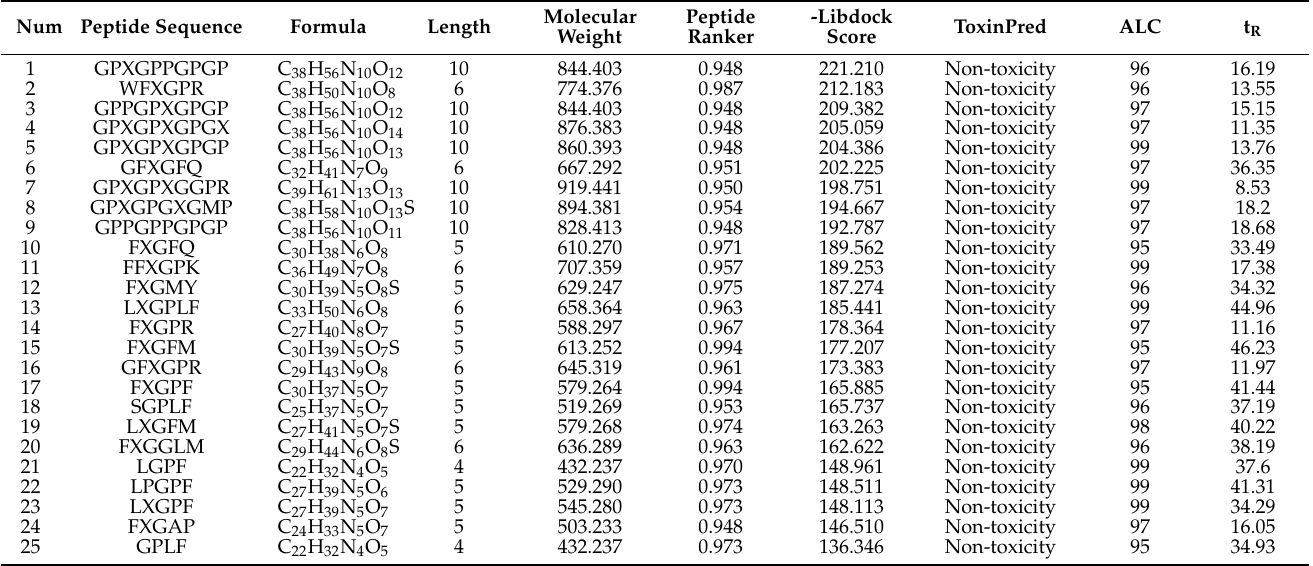
Table 3. Screening peptides by peptide ranker and molecular